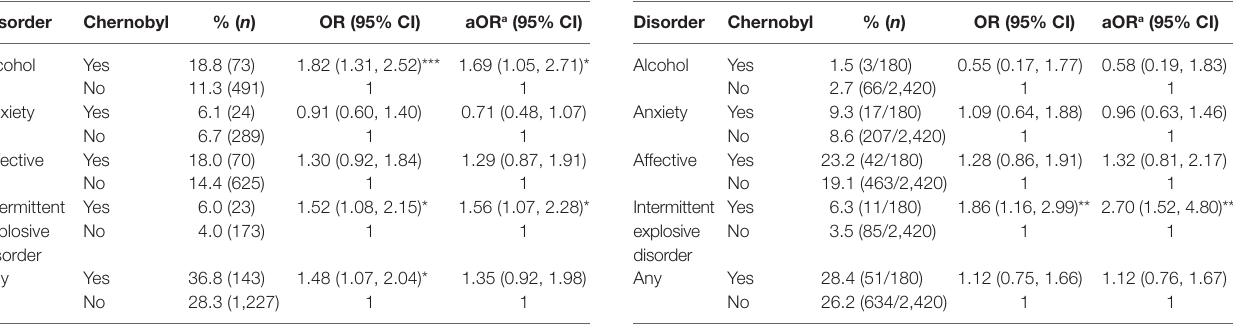
TaBle 4 | Female prevalence model.